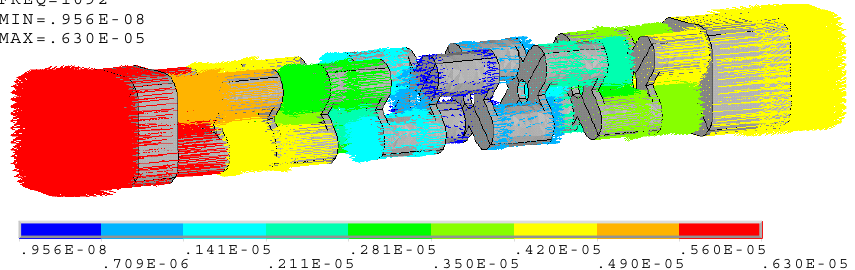
Figure 6. Vector illustration of vibration at 1092 Hz (cascade-connected transducer with ten segments).